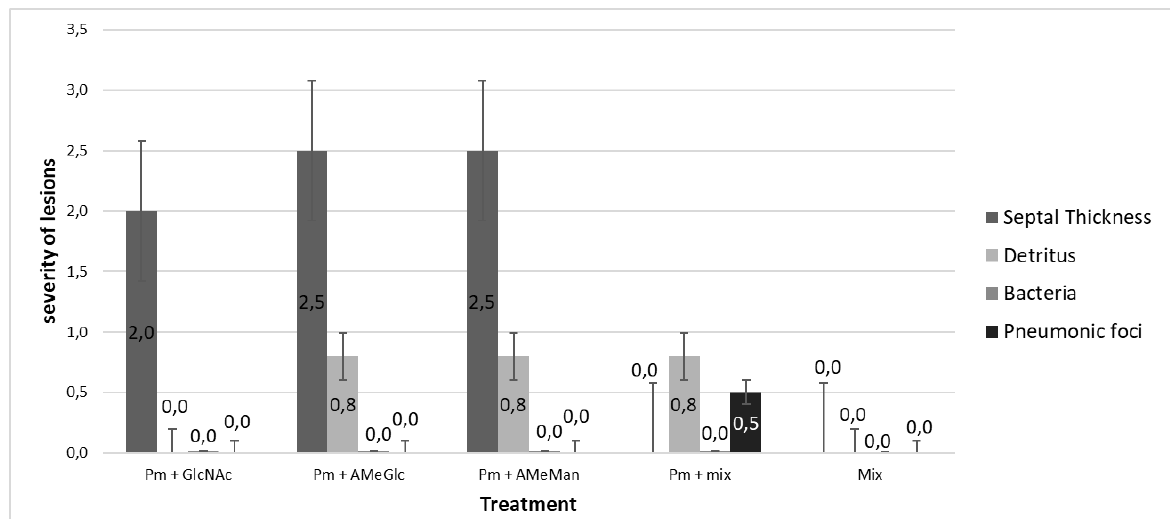
Figure 8. Comparison of the severity of microscopic lesions in lungs among animals treated with P. multocida plus individual carbohydrates and animals treated with P. multocida plus the mixture of carbohydrates (P<0.05). Mix= mixture of carbohydrates. P. multocida (Pm) , N-acetylglucosamine (GIcNAc), alphamethylglucoside (AMeGIc), alphamethylmannoside